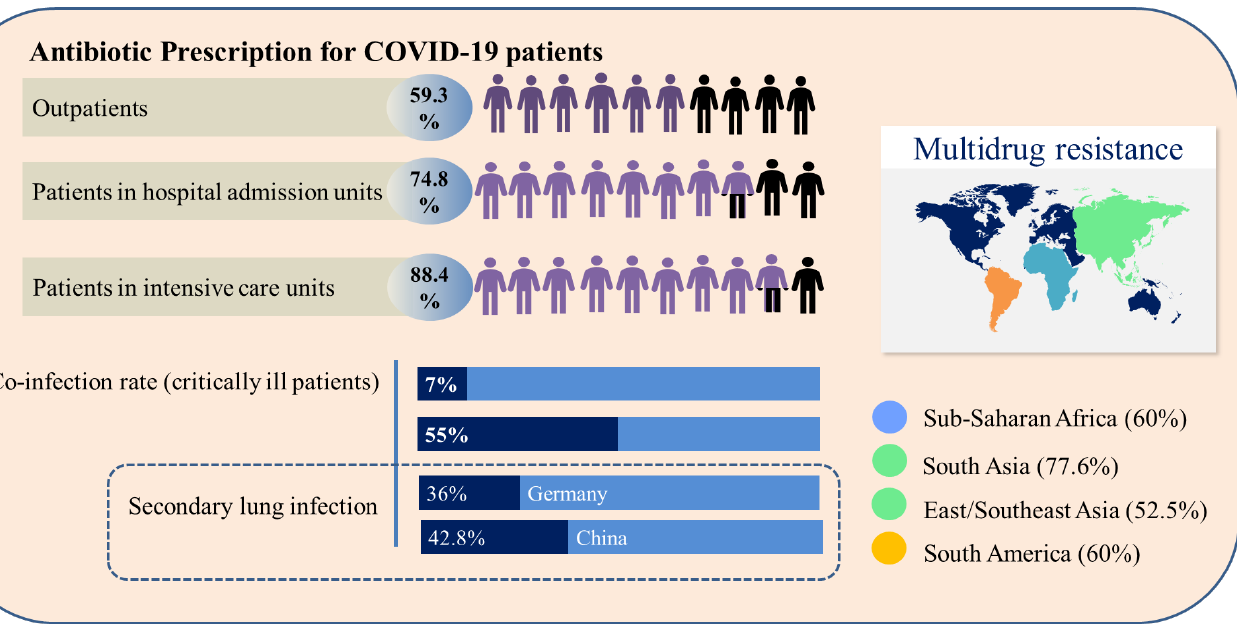
Figure 2. Comparative overview of antibiotic prescription, co-infection and secondary infection profile and geographic incidence of multidrug resistance related to COVID-19 patients.